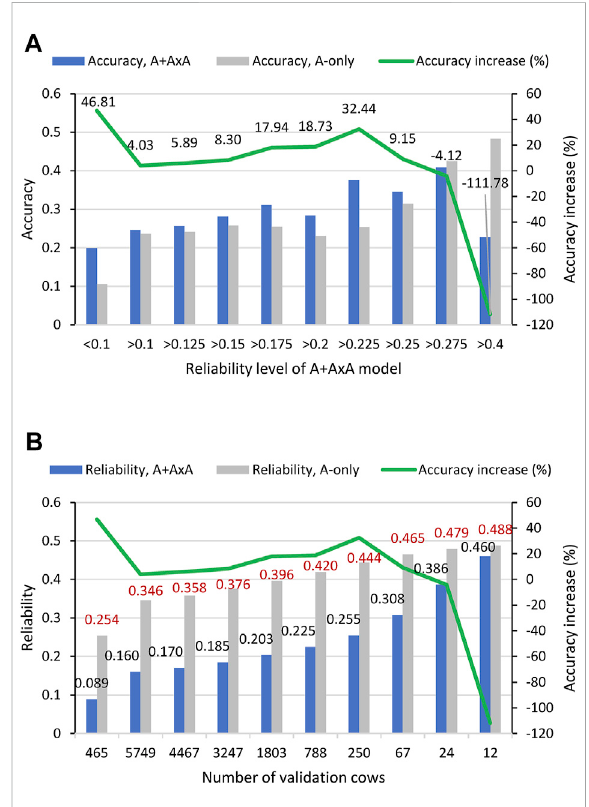
FIGURE 2 Accuracy of predicting RFI phenotypic values form 10-fold validation studies using 6215 Holstein cows for different reliability levels. (A) Accuracy of predicting RFI phenotypic values by the A + A×A and A-only models for different reliability levels of the GBLUP of total genetic values under the A + A×A model. The 6215 validation cows from the 10-fold validations were fi rst sorted by the reliability of the GBLUP of thetotal genetic values under the A + A×A model, and the correlation between the GBLUP and phenotypic values of validation cows at each reliability level was calculated. Then the 6215 validation cows from the 10-fold validations were sorted by the reliability of the GBLUP of the additive values under the A-only model, and the correlation between the GBLUP and phenotypic values for the same number of validation cows at each reliability level of the GBLUP of total genetic values was calculated. The prediction accuracies of the two models were compared for the same number of cows. (B) Reliability of the GBLUP of total genetic values under the A + A×A model and additive reliability under the A-only model for thesame numbers of cows. “ Accuracy ” is de fi ned by Eq. 4. “ Accuracy increase ” = 100 × [(accuracy of A + A × A model) — (accuracy of A-only model)]/(accuracy of A-only